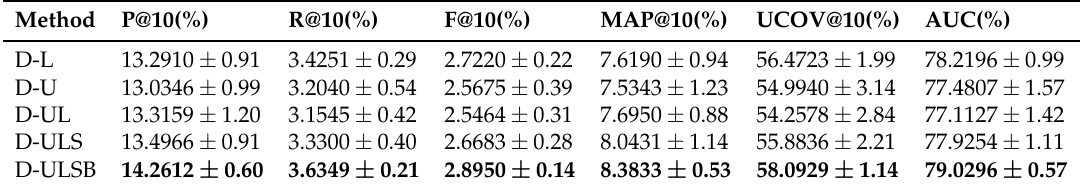
Table 5. The influence of the four components in DTNMR (D denotes DTNMR for short, the component names after “-” mean the corresponding component is turned on, where S is user short-term preference, L is user long-term preference, U is user intrinsic preference and B is the behavior types).